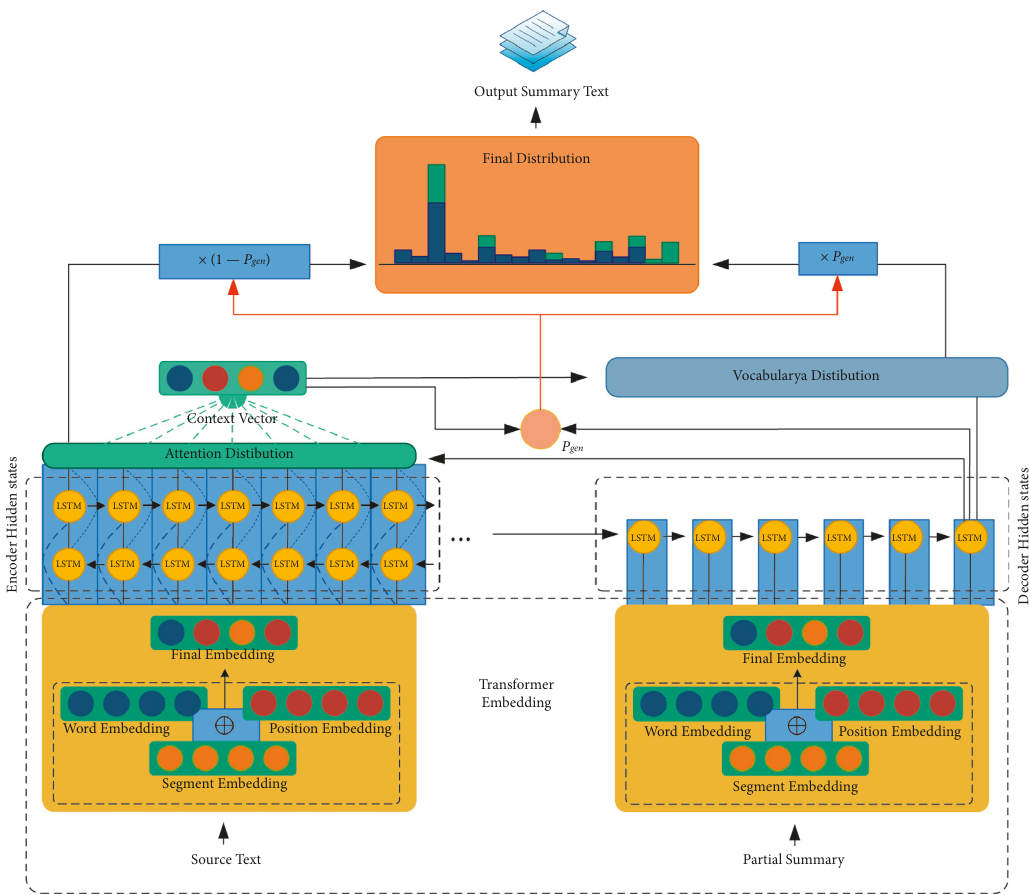
Figure 2: Architecture of the feature extraction model and transformer-based pointer generator network, for government message, preprocessing. We get the embedding of the final text and input it into the text classification method.